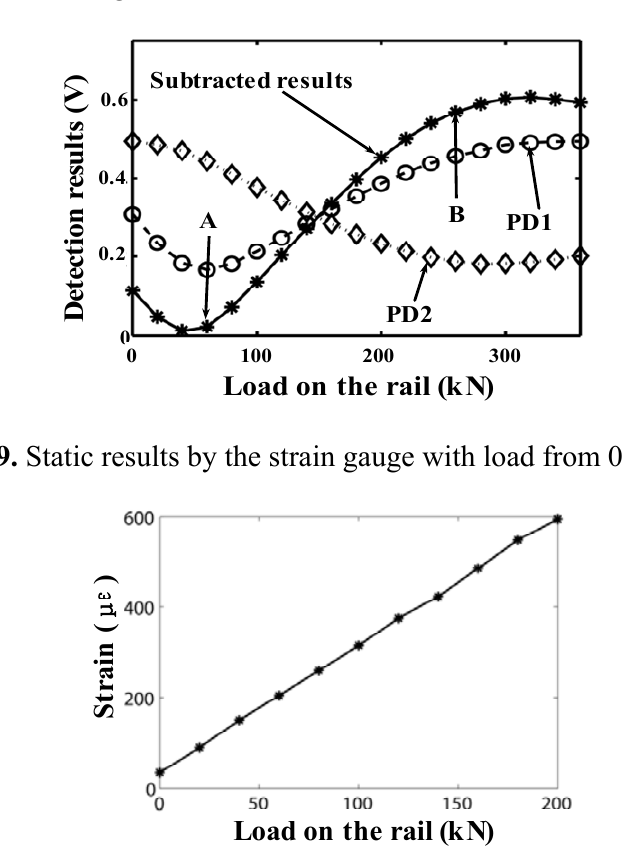
Figure 8. Detected signal values of PD1 and PD2 as a function of the rail load.